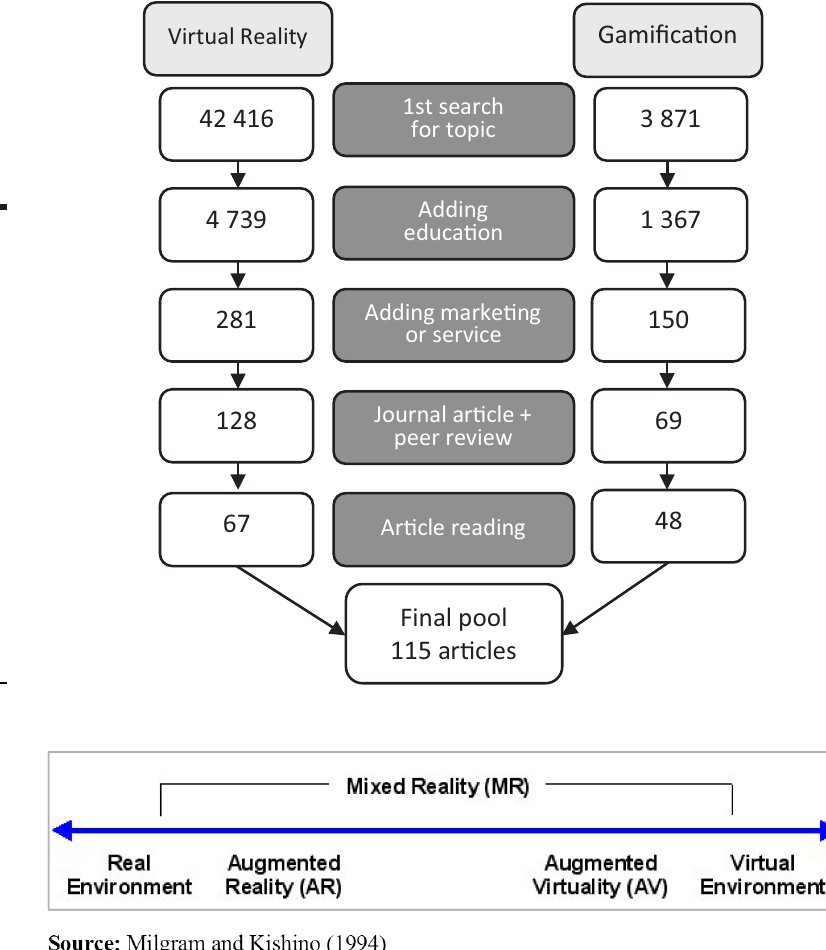
Figure 4. Reality – virtuality continuum